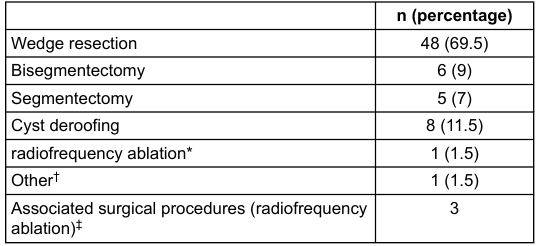
Table 2: Types of laparoscopic procedure.